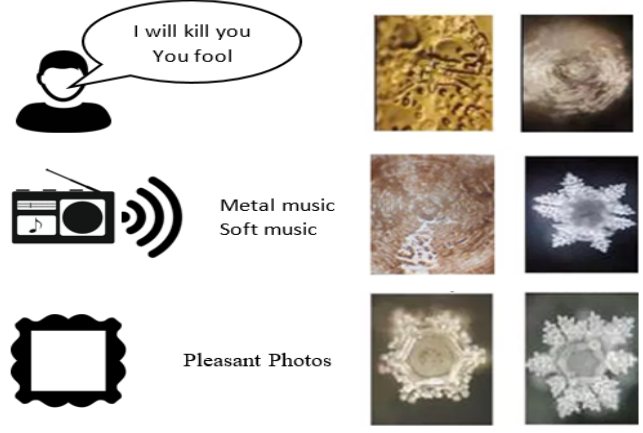
Figure 2. Experiment-Hidden Messages